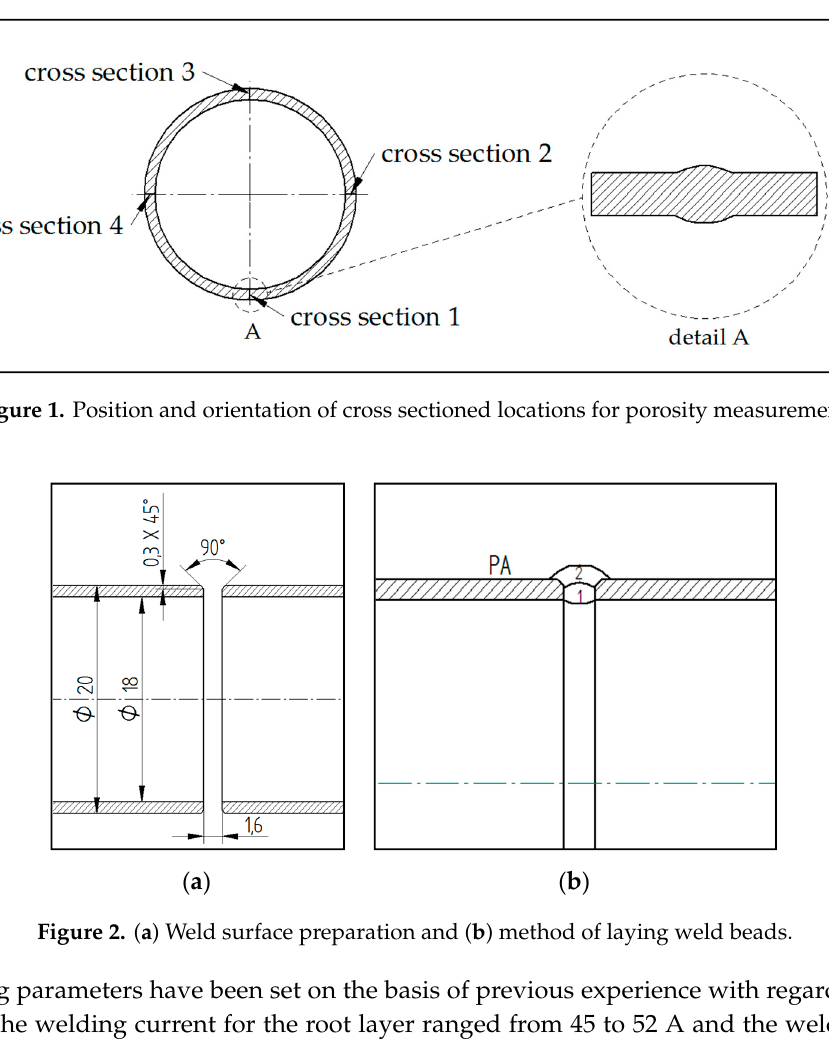
Figure 1. Position and orientation of cross sectioned locations for porosity measurement.